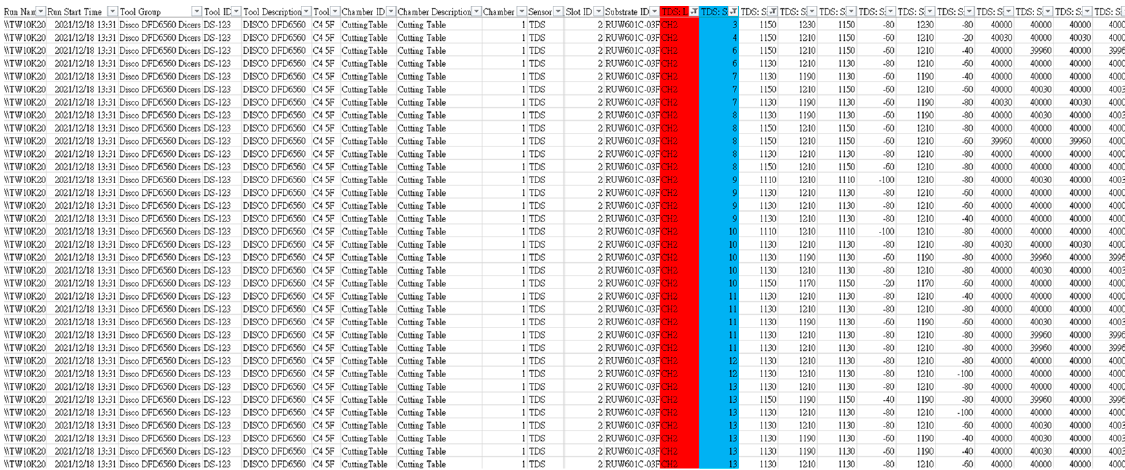
Figure 11. Wafer grinding signals.